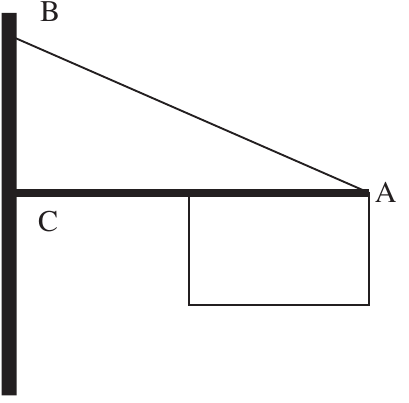
FIG. 6. Store sign supported by a